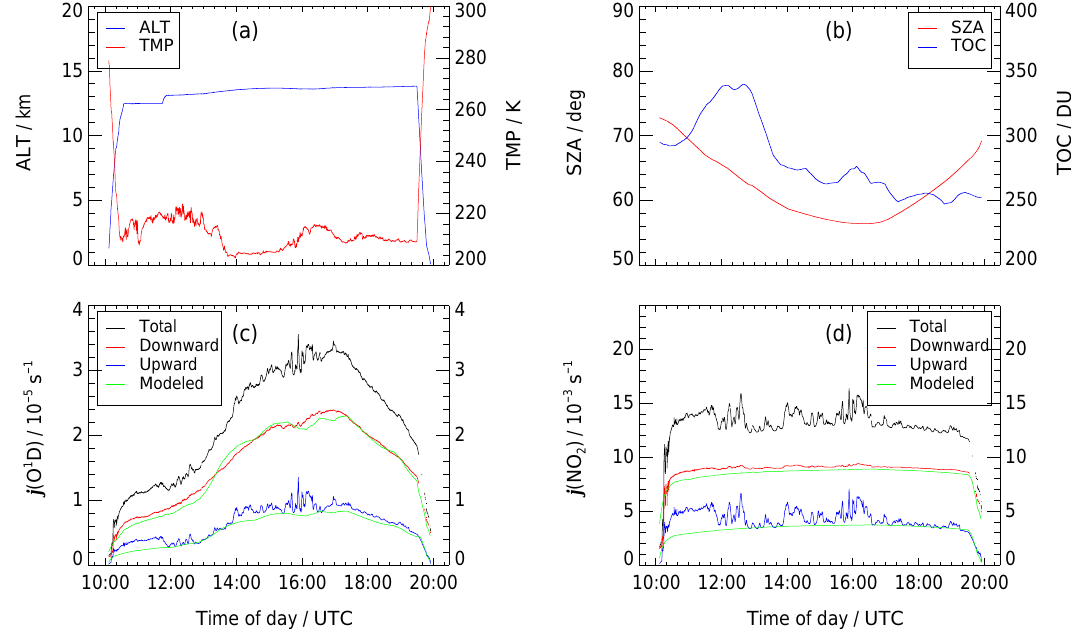
Figure 15. Example data from a HALO research flight on 19 December 2013 from Oberpfaffenhofen (Germany) to Barbados. Altitude (ALT) and static temperature (TMP) in panel (a) , as well as the solar zenith angle (SZA) and total ozone column (TOC) in panel (b) , are important boundary conditions and parameters used in the data evaluation. Photolysis frequencies j (O 1 D) and j (NO 2 ) in panels (c) and (d) were calculated for the corresponding static temperatures. Rapid fluctuations of upward components of photolysis frequencies were induced by underlying clouds. Modeled data are clear-sky upward and downward components of photolysis frequencies from radiative transfer calculations.